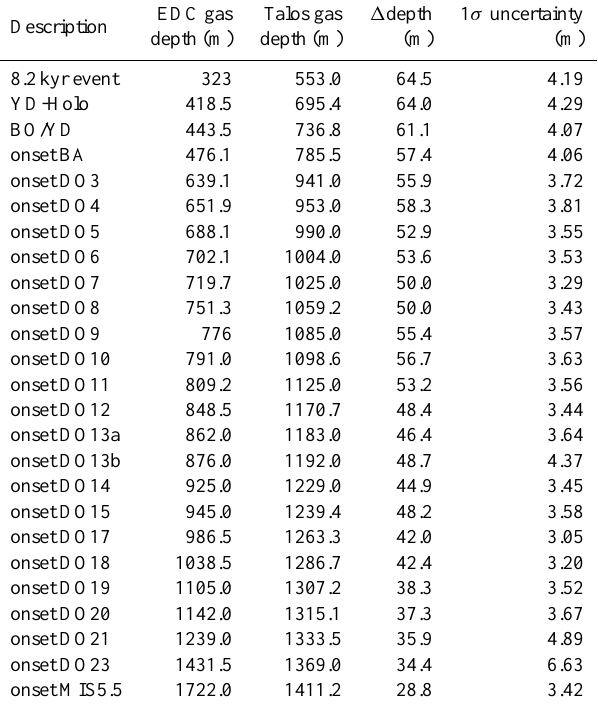
Table 2. Isotopic synchronisation tie points between the TALDICE and EDC99 ice cores.